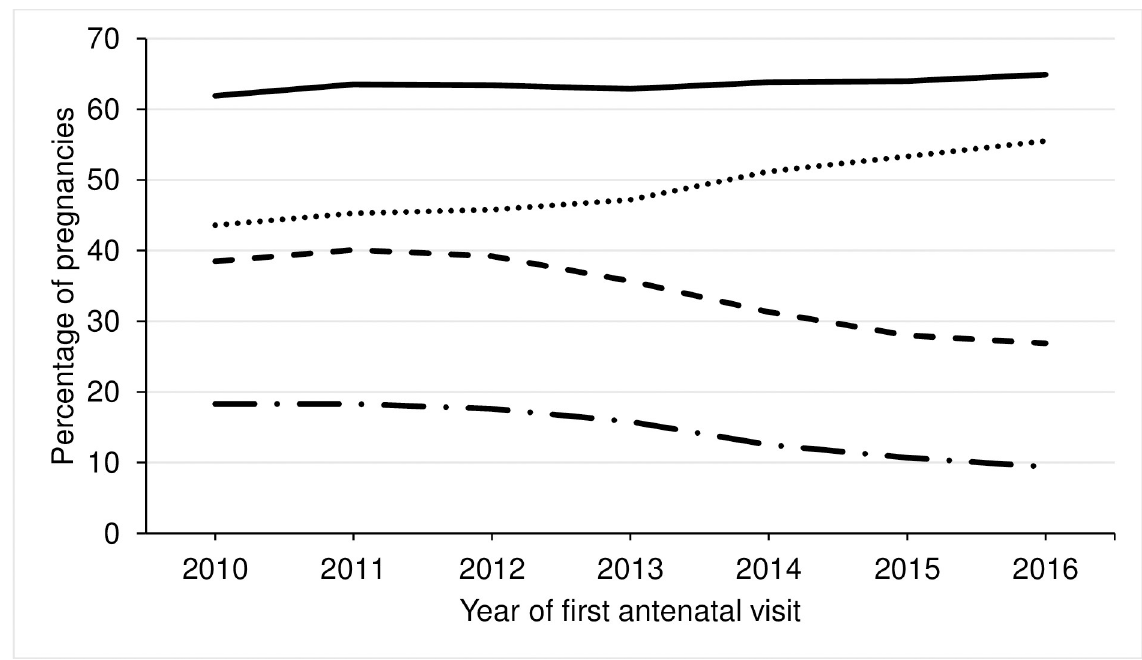
Fig 1. Percentage of pregnancies with any medication, non-supplement medication, any supplements (vitamins, iron or folic acid) and only supplements recorded by year of first antenatal visit. Solid black line = any medication; Dotted black line = non-supplement medication; Dashed black line = any supplements; Long dashed black line = only